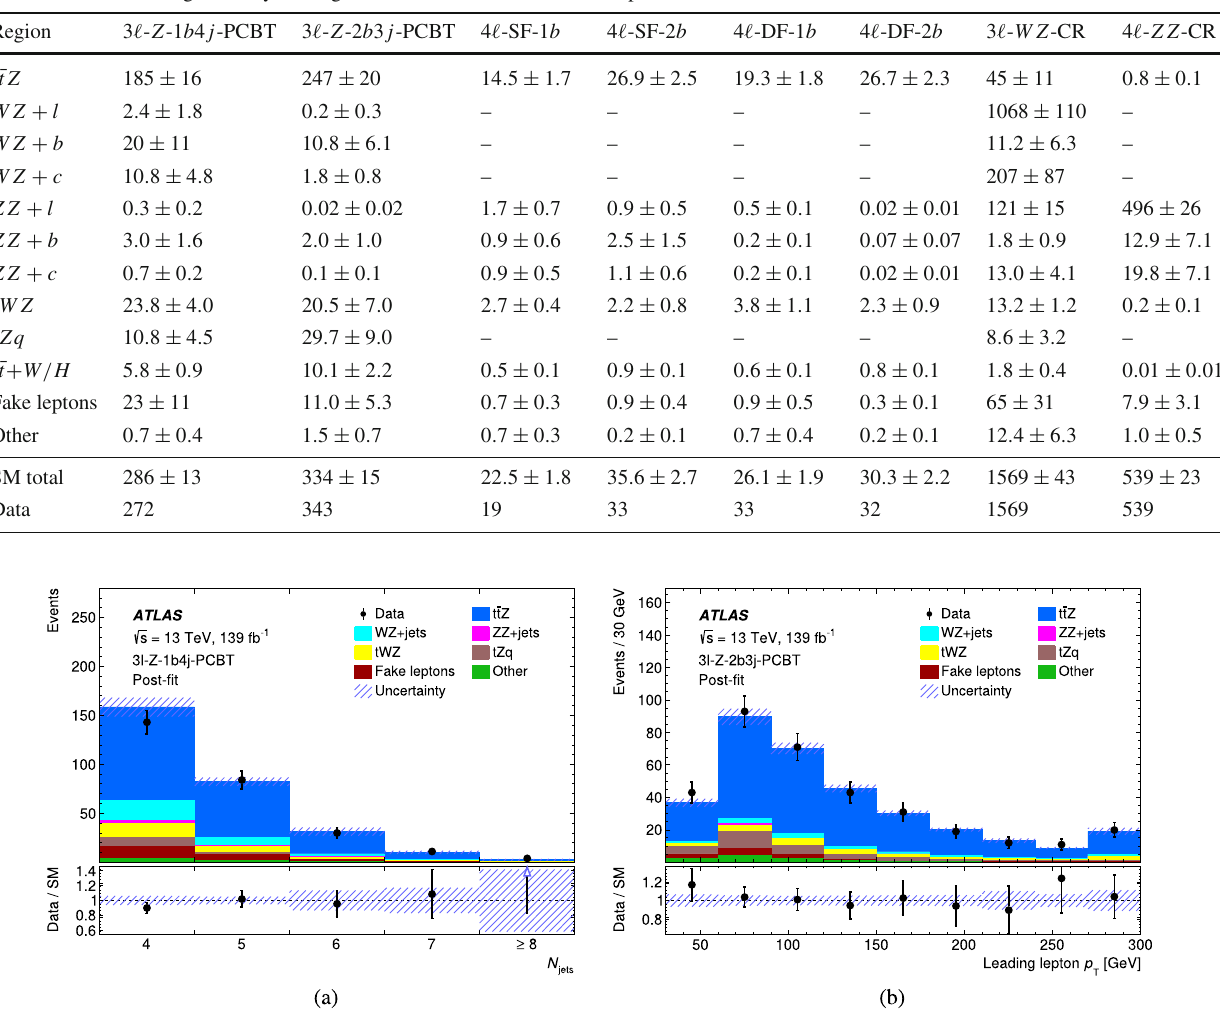
Table 5 The observed and expected numbers of events in the trilepton and tetralepton signal regions, as well as the W Z / Z Z + jets control regions, after the combined fit. The definitions of the background cate- gories are the same as in Table 4. Categories with event yields shown as ‘–’ do not contribute significantly to a region. The indicated uncertain-